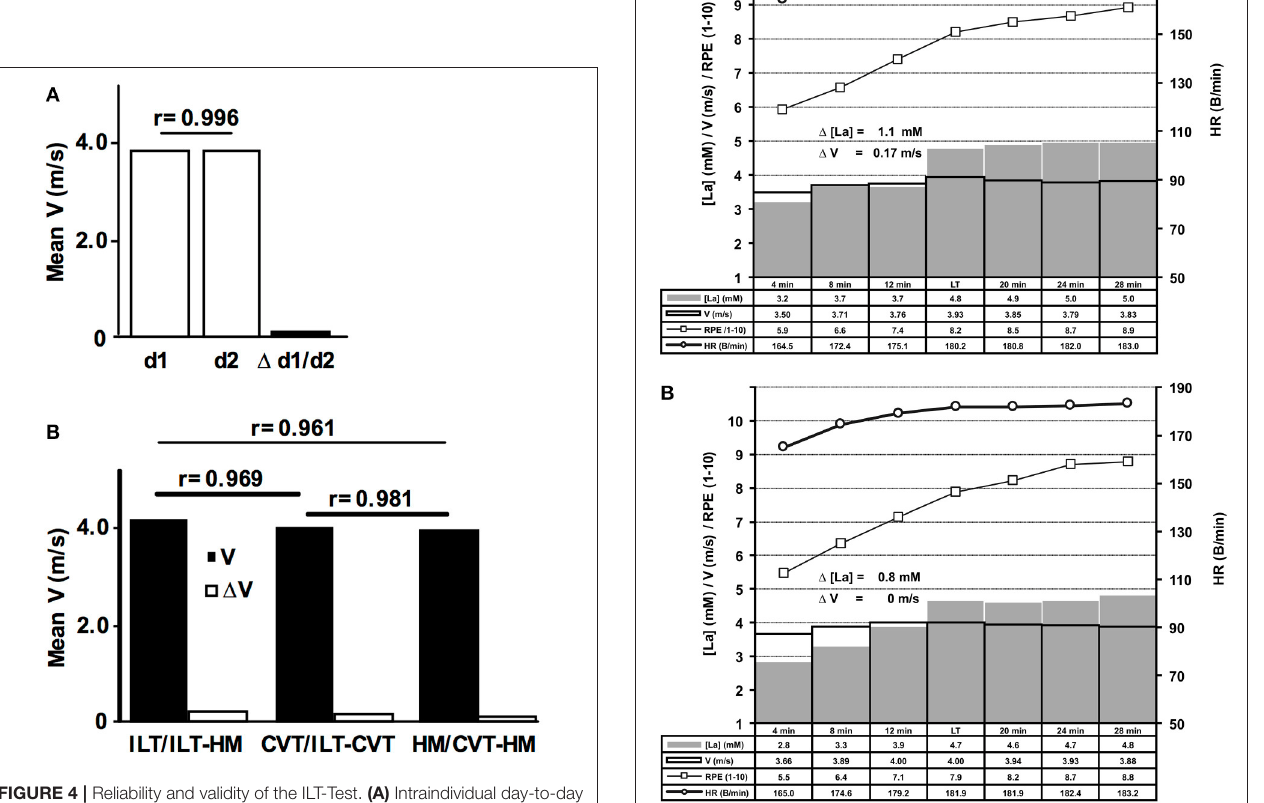
FIGURE 4 | Reliability and validity of the ILT-Test. (A) Intraindividual day-to-day comparison of the maximal lactate steady state workload (MLSS W ) obtained